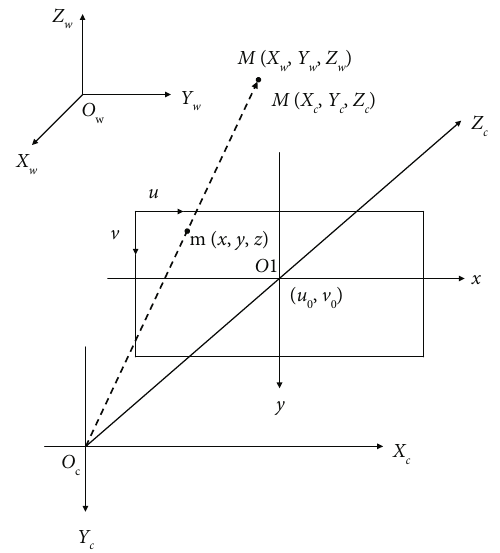
Figure 5: The relationship diagram among the image, the camera, and the world coordinate system.